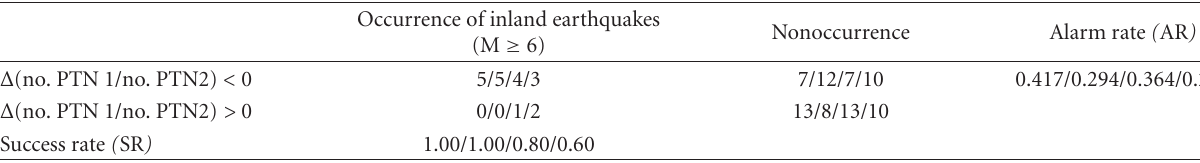
Table 3: Contingency table showing the relationship between proposed potential conditions associated with the occurrence of M ≥ 6.0 inland mainshocks for four pairs of geodetic and seismic quantities and their actual occurrence times. The four figures for each element correspond to the following four pairs of geodetic and seismic quantities from left: the absolute value of dilatation rate and seismic energy, maximum shear strain rate and seismic energy, absolute value of dilatation rate and the number of earthquakes, and maximum shear strain rate and the number of earthquakes. A proposed potential condition occurring prior to the occurrence of inland mainshocks, Δ (no. PTN1/no. PTN2) < 0, implies that the trend of no. PTN1/no. PTN2 is negative (Figure 5). Occurrence of inland earthquakes Nonoccurrence Alarm rate ( AR ) (M ≥ 6) Δ (no. PTN 1/no. PTN2) < 0 5/5/4/3 7/12/7/10 0.417/0.294/0.364/0.231 Δ (no. PTN 1/no. PTN2) > 0 0/0/1/2 13/8/13/10 Success rate ( SR ) 1.00/1.00/0.80/0.60 Probability gains of AR and SR: 3.56/2.49/3.00/1.97 and